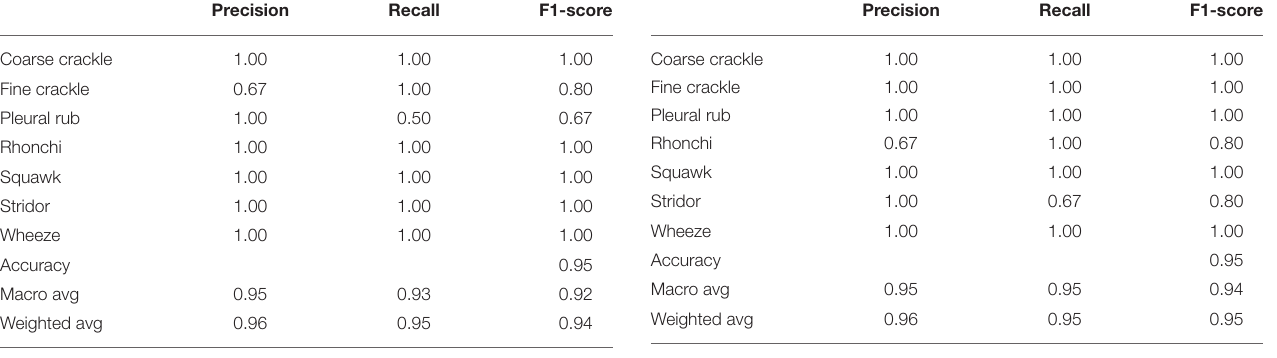
TABLE 5 | Comparative results obtained (Precision and Recall) for VGG-D1. TABLE 6 | Comparative results obtained (Precision and Recall) for InceptionNet.